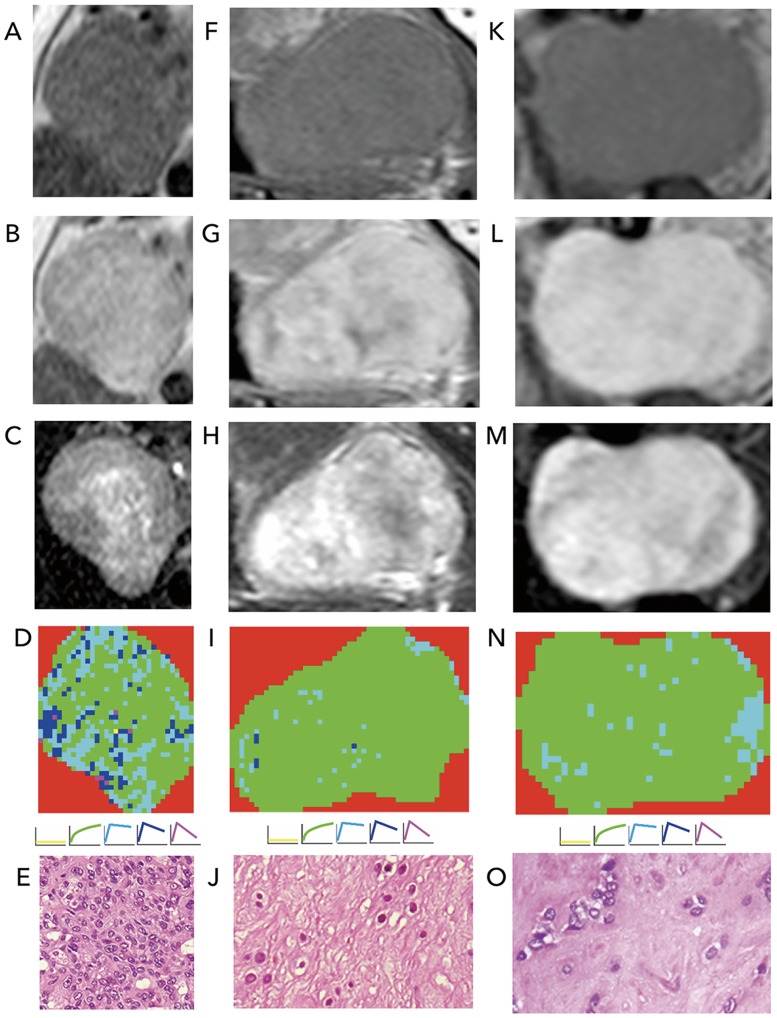
Conventional MR imaging and TIC analysis.A-E, 72-year-old man with carcinoma ex pleomorphic adenoma (CXPA) in right submandibular gland. Tumor is homogeneous (A), irregularly enhanced (B), and heterogeneous (C) on T1 (T1WI)-, contrast-enhanced T1 (CET1WI)-, and fat-suppressed T2-weighted (fsT2WI) images, respectively. TIC mapping indicates tumor consisting of 0.2% Type 1, 57.2% Type 2, 26.9% Type 3, 15% Type 4, and 0.8% Type 5 (overall TIC profile = cell-rich type, D). Photomicrograph shows tumor area with high cellularity (E, H & E staining). Tumor was correctly diagnosed by stepwise differentiation algorithm. F-J, 61-year-old man with CXPA in left parapharyngeal space. Tumor is homogeneous (F), irregularly enhanced (G), and heterogeneous (H) on T1WI, CET1WI, and fsT2WI, respectively. TIC mapping indicates tumor consisting of 2.8% Type 1, 93.4% Type 2, 2.6% Type 3, 0.8% Type 4, and 0.4% Type 5 (overall TIC profile = matrix-rich type, I). Photomicrograph shows tumor area rich in fibro-hyalinous tissues (J, H & E staining). Tumor was misdiagnosed by stepwise differentiation algorithm. K-O, 34-year-old man with PA in left parotid gland. Tumor is homogeneous (K), irregularly enhanced (L), and heterogeneous (M) on T1WI, CET1WI, and fsT2WI, respectively. TIC mapping indicates tumor consisting of 0.0% Type 1, 94.2% Type 2, 5.8% Type 3, 0.0% Type 4, and 0.0% Type 5 (overall TIC profile = matrix-rich type, N). Photomicrograph shows tumor area rich in fibromyxoid tissues (O, H & E staining). Tumor was correctly diagnosed by stepwise differentiation algorithm.